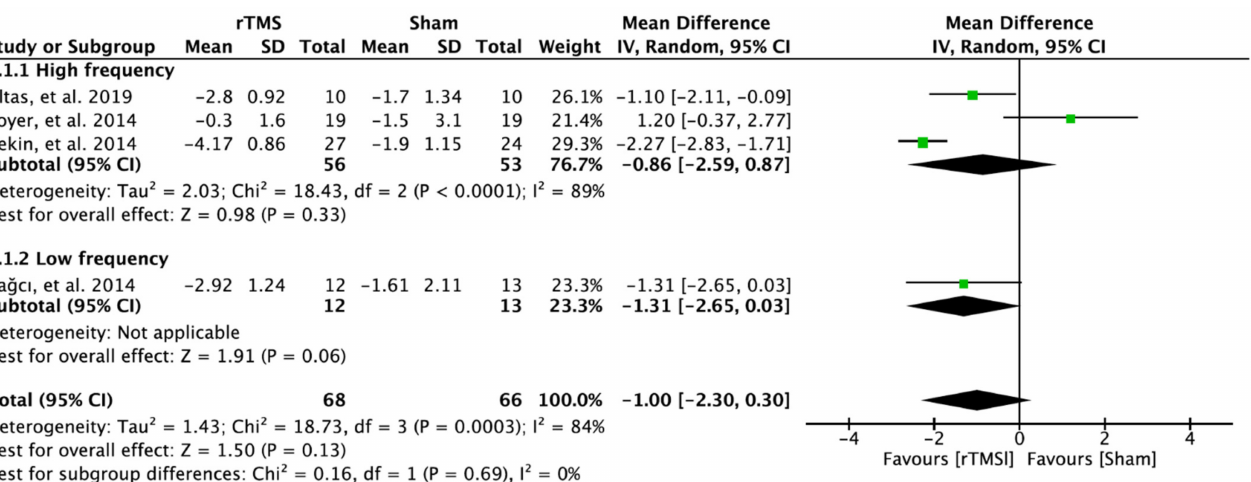
Figure 3. Forest plot on the effect of repetitive transcranial magnetic stimulation on